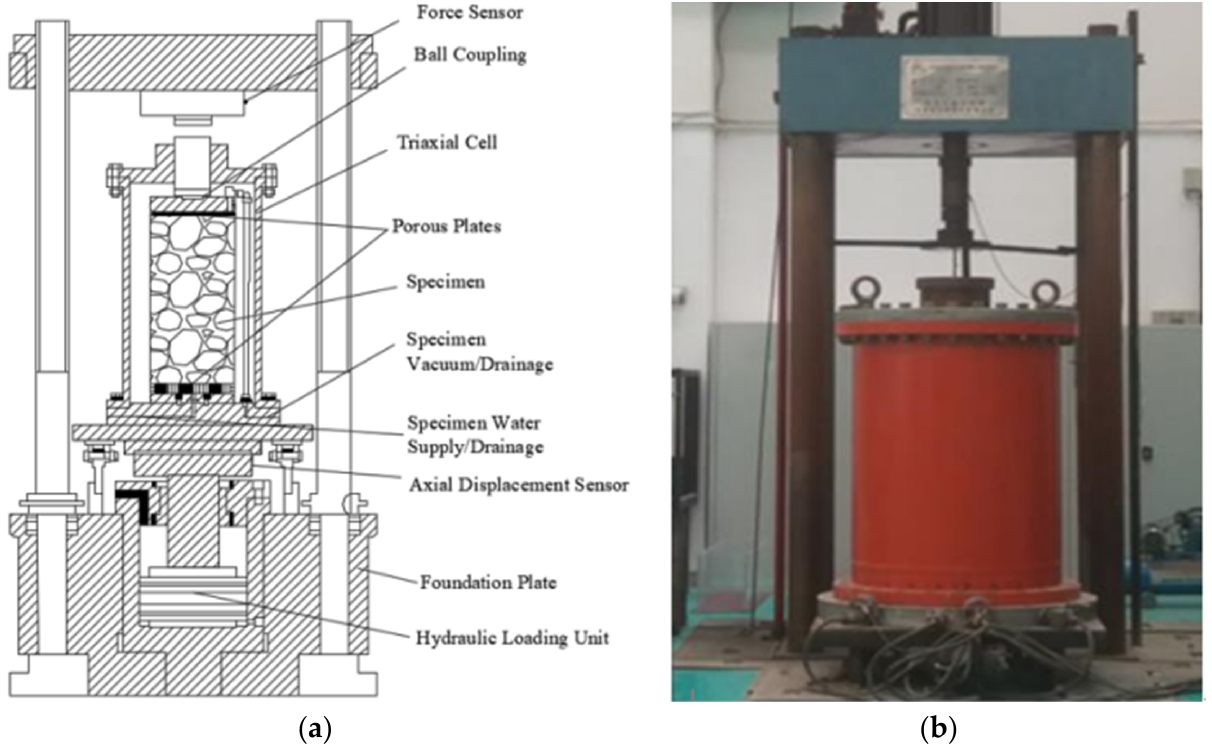
Materials 2022 , 15 , x FOR PEER REVIEW 4 of 10 Figure 1. Large-scale triaxial compression apparatus: ( a ) overall view of the apparatus; and ( b ) pressure stabilization techniques.